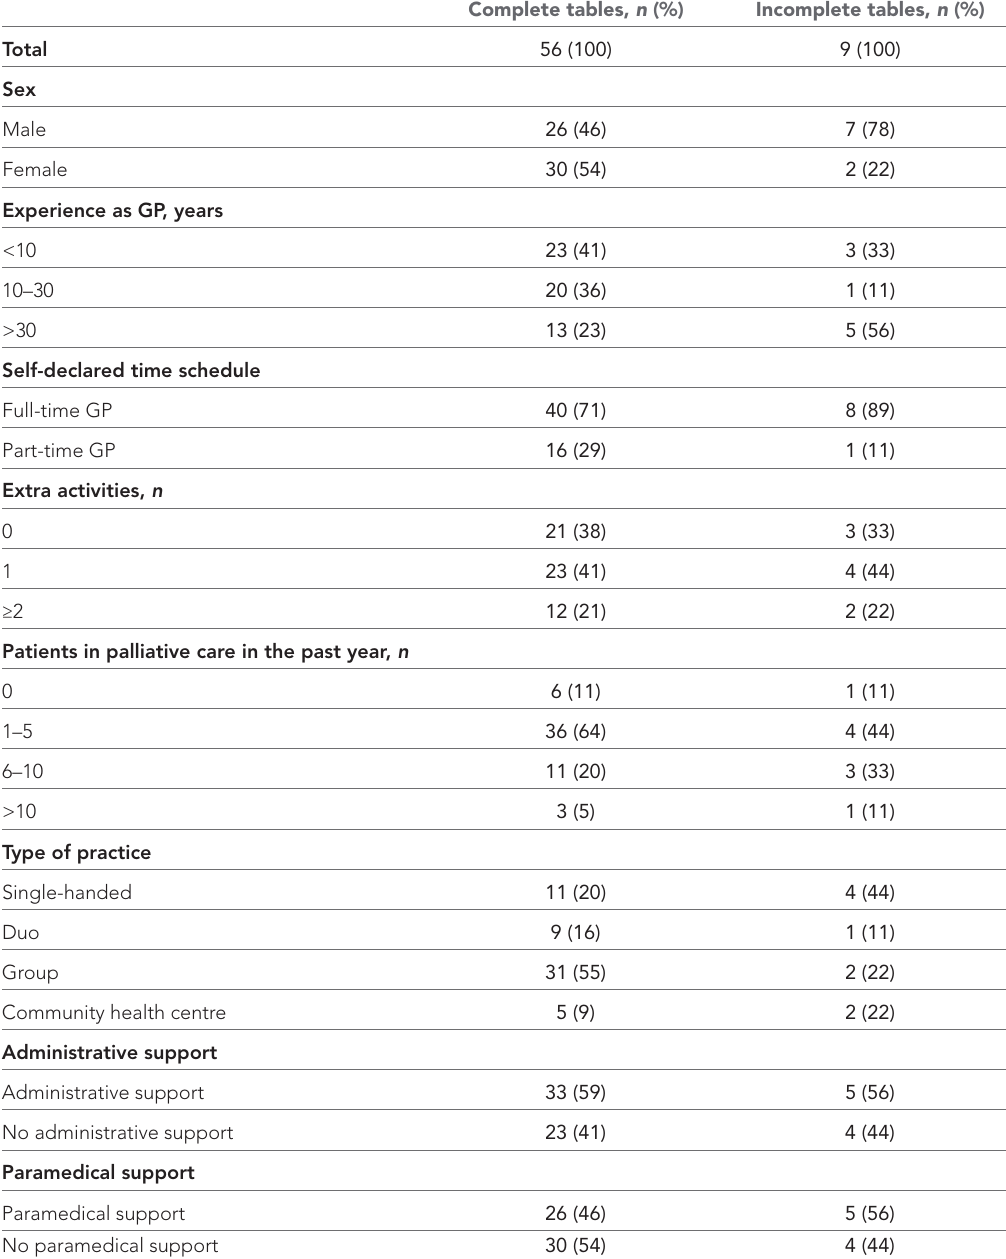
Table 1 Participant characteristics compared between GPs with complete summary tables and GPs with incomplete summary tables